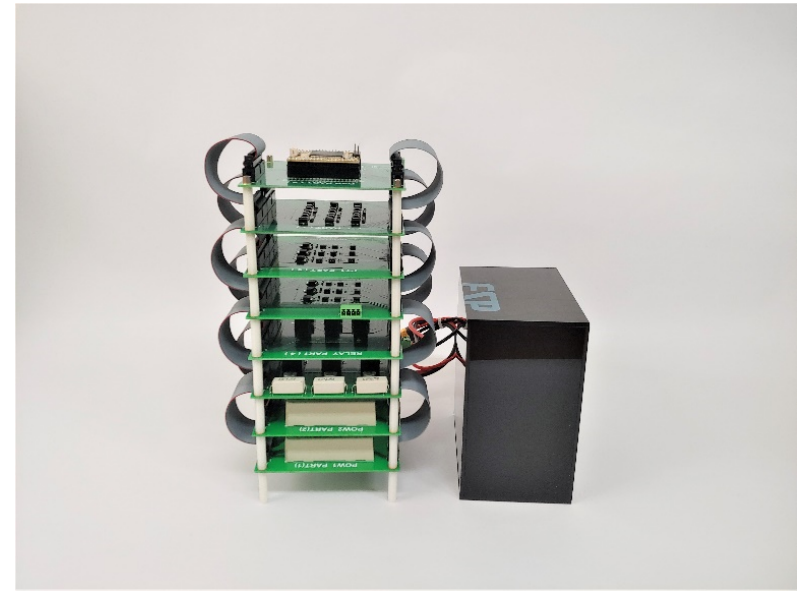
Figure 18. Prototype of the micro DG.